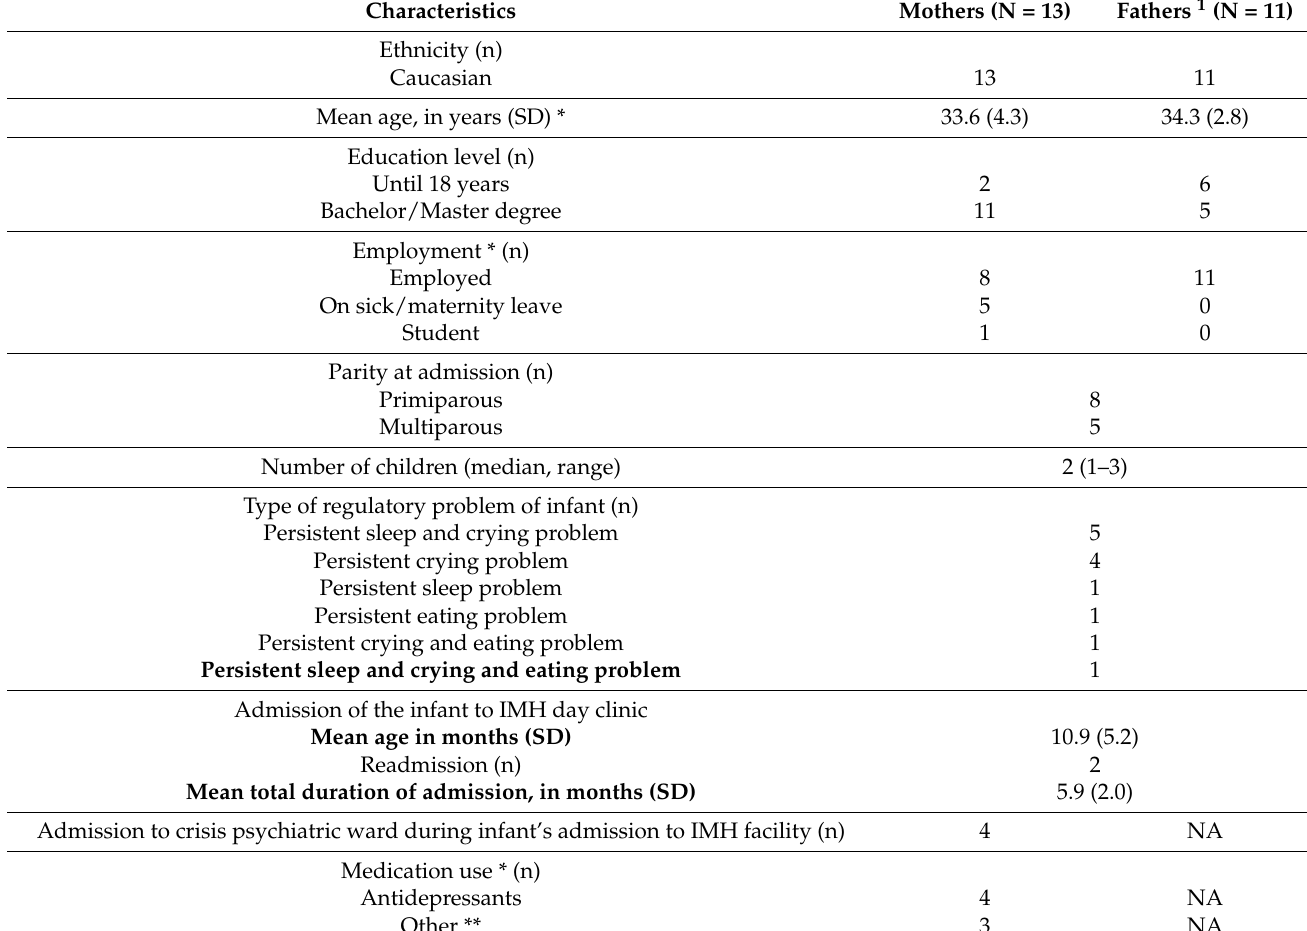
Table 2. Socio-demographic and IMH day clinic characteristics of the mothers and their families. Characteristics